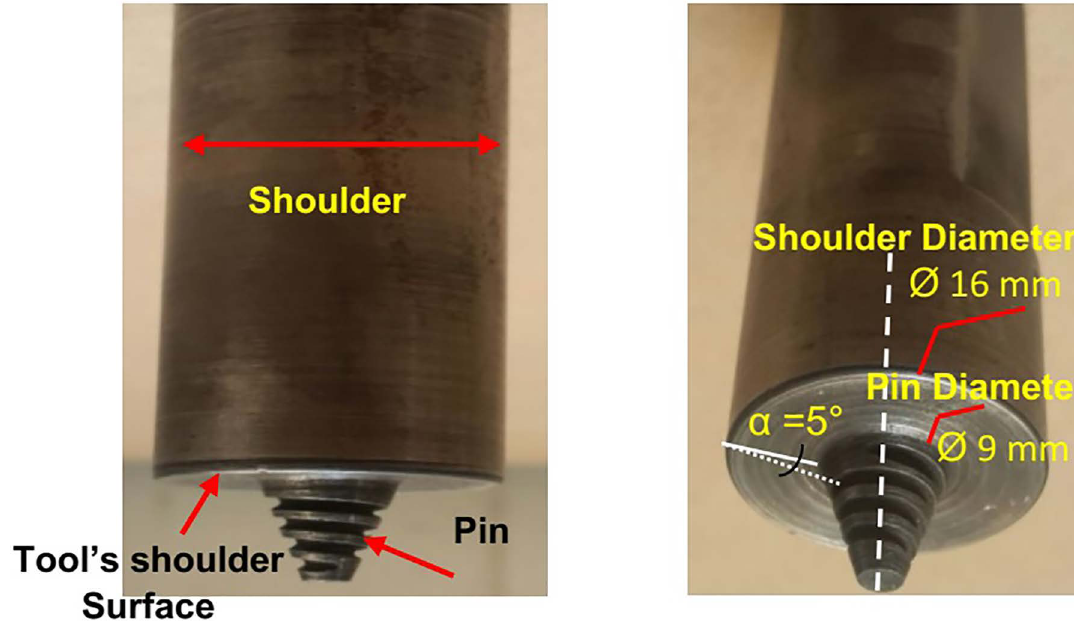
Figure 1. Geometry of the pin tool were used in this study.